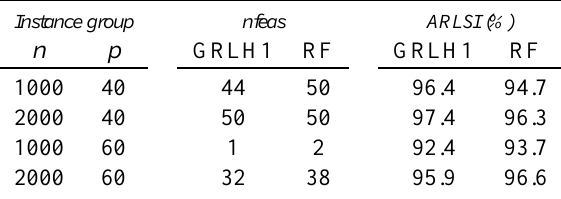
Table 15. Comparison between GRLH1 and RF